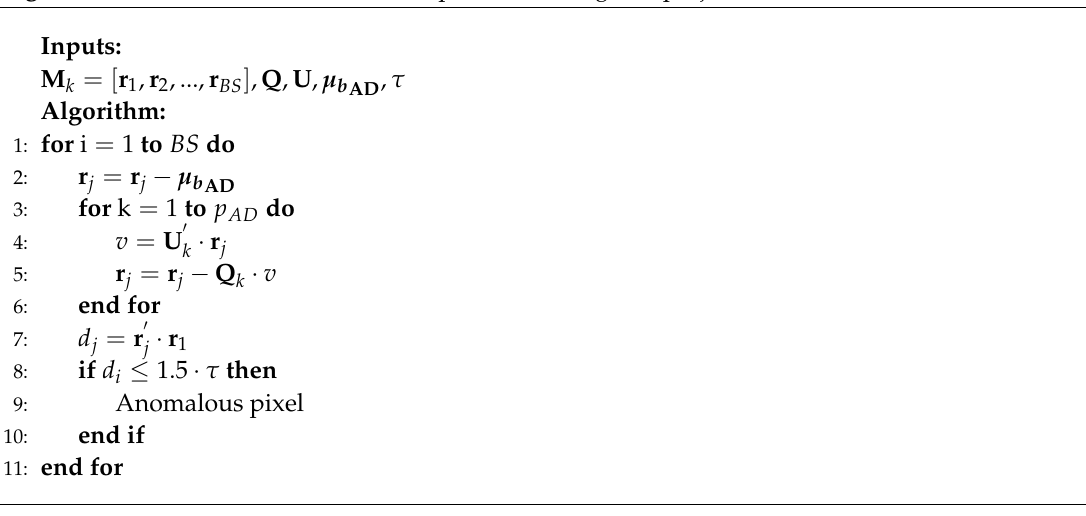
Algorithm 3 Alternative method to compute the orthogonal projection